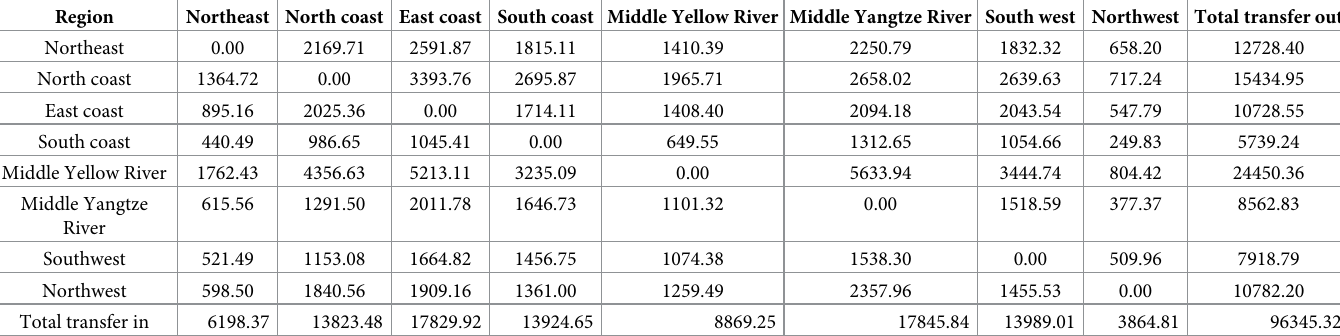
Table 2. Embodied carbon trade among eight regions in China in 2015 (unit: 10,000 tons). Region